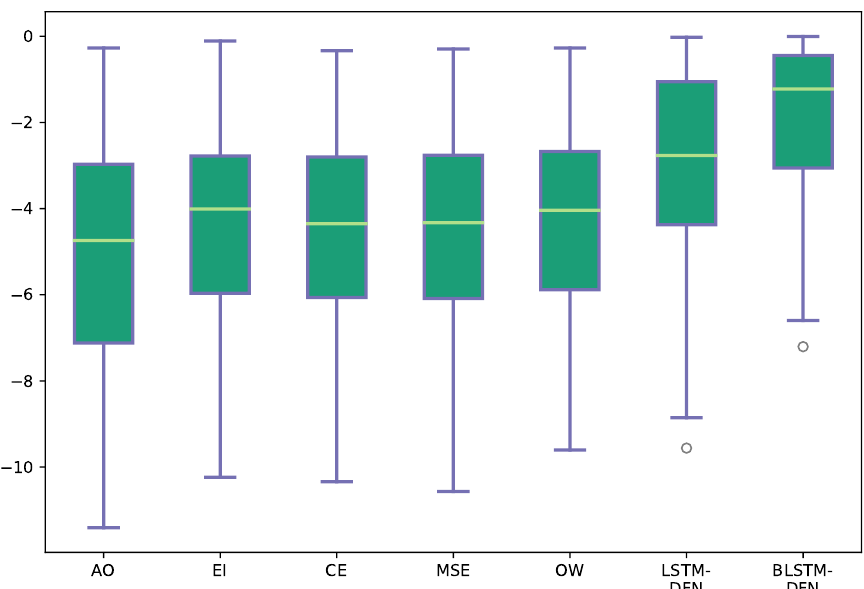
− 9 dB. t , with additive noise at